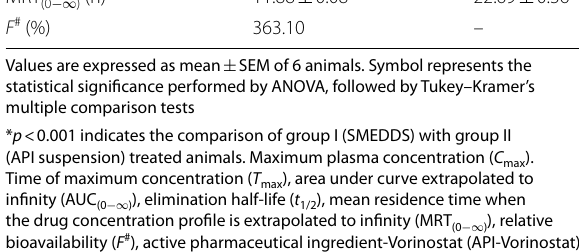
multiple comparison